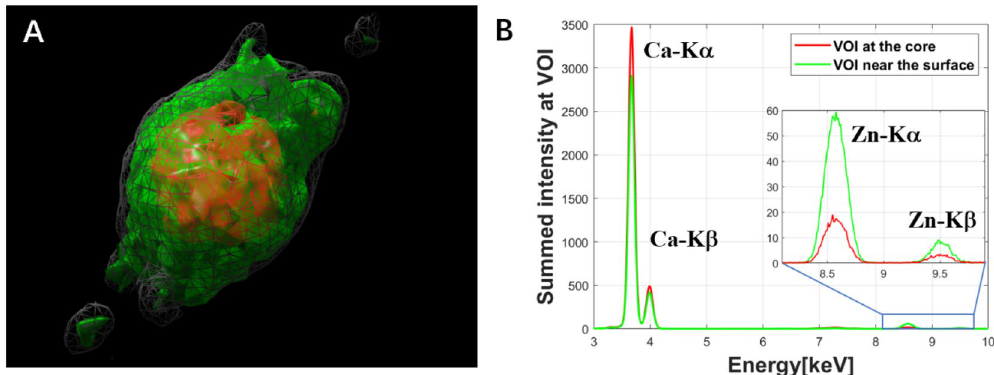
Figure 7. Extraction of the mean XRF spectra within the volume of interest of the reconstructed calcification micro-sphere shown in Fig. 5D,E. ( A ) Reconstructed result by MLEM algorithm from the total intensity of the XRF spectra, grey volume: reconstructed total sphere volume, red and green volumes: core and surface rim regions, respectively. ( B ) Comparison of the mean XRF spectra of the core (red) and surface rim (green)